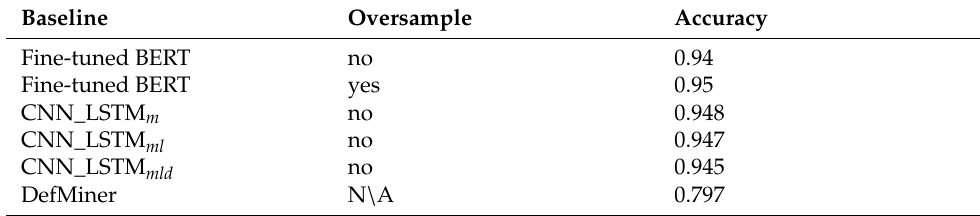
Table 5. Final results for the WCL